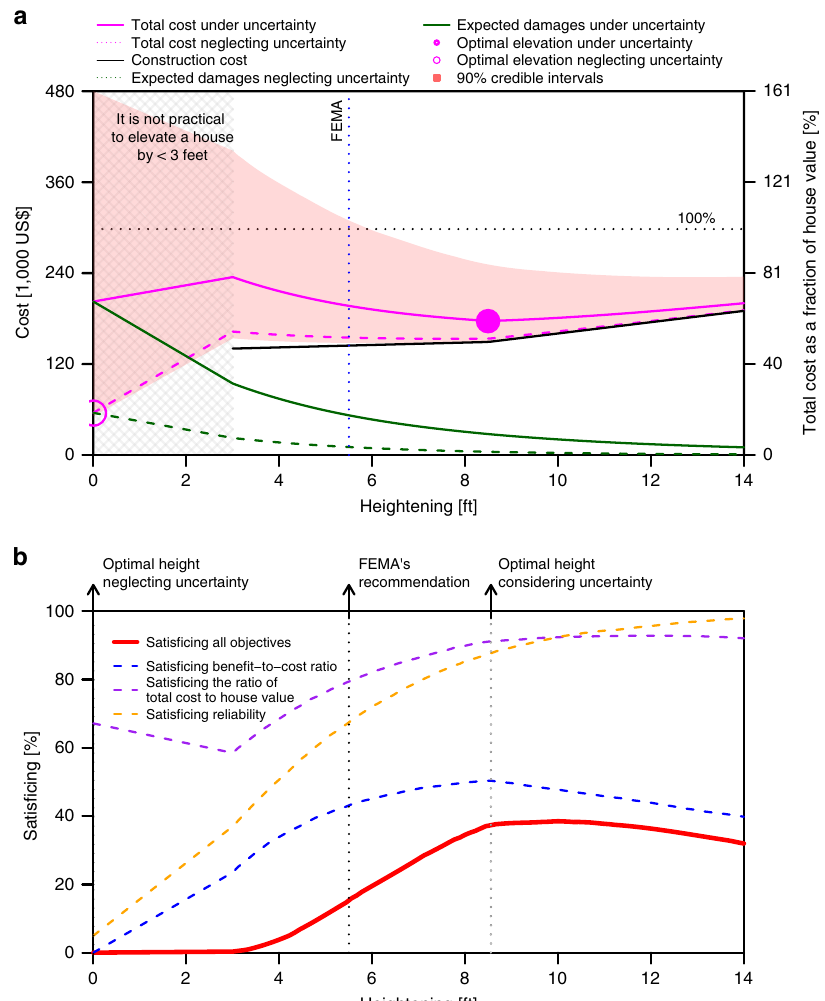
Fig. 3 Cost and robustness analysis of heightening strategies. a Total cost and the optimal elevation under assumptions of ignoring-uncertainty (dashed magenta line and the hollow point) and considering-uncertainty (solid magenta line, shaded bounds, and the fi lled point). The considered hypothetical house is 1500 ft 2 with a worth of $300 K and with the lowest fl oor at four feet below the Base Flood Elevation. Under the ignoring-uncertainty assumption, the house lifetime and discount rate are assumed to be 30 years and 4% per year, respectively. The vertical line indicates the FEMA-recommended heightening strategy. The hatched gray area on the left refers to elevating the house by less than three feet which we assume is impractical in this study. b Robustness of different objectives are shown by dashed lines. The solid red line indicates the robustness of all